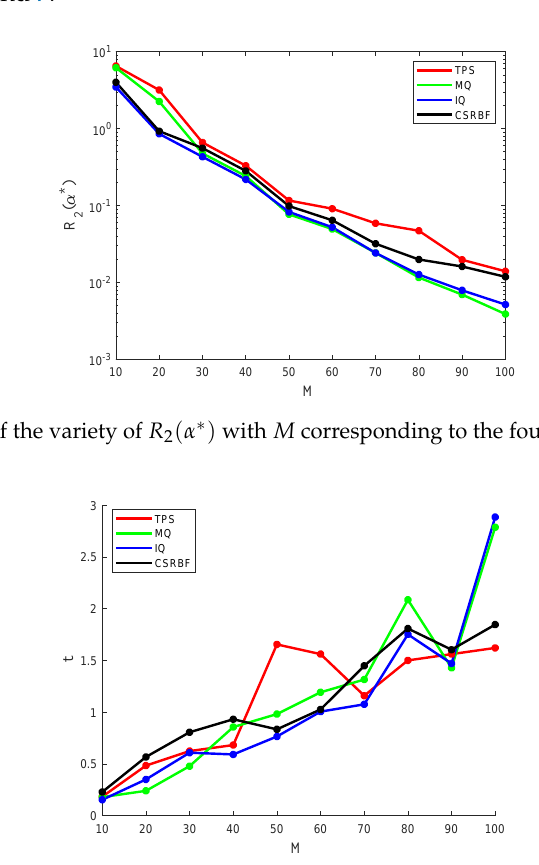
Figure 7. The graph of the variety of computational time with M corresponding to the four kinds of basis functions under N =